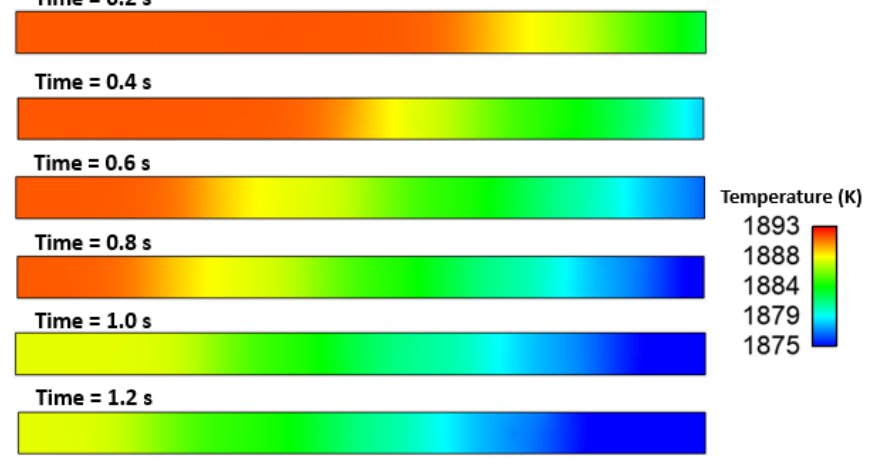
Figure 10. Temperature distribution in the domain (S: 10 PPM).